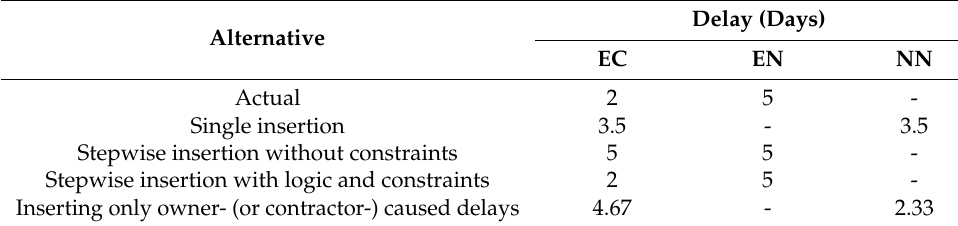
Table 1. Summary of the results of delay